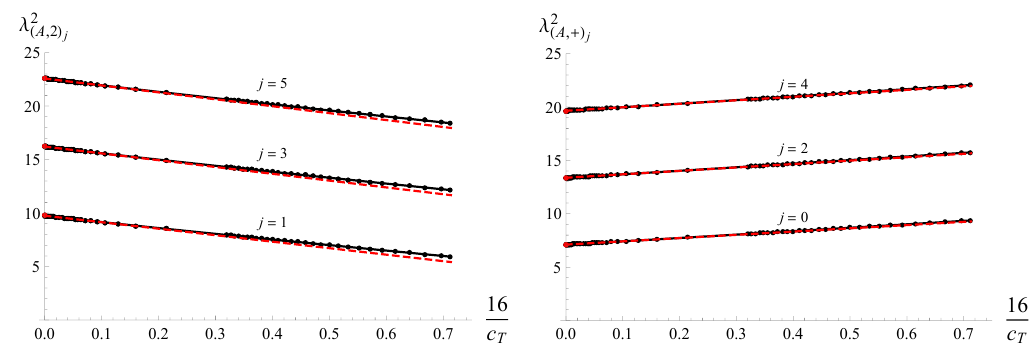
Figure 4 . The (cid:21) 2 and (cid:21) 2 OPE coe(cid:14)cients with spins j = 1 ; 3 ; 5 and j = 0 ; 2 ; 4, re- ( A; 2) j ( A; +) j spectively, in terms of the stress-tensor coe(cid:14)cient c T , where the plot ranges from the generalized free (cid:12)eld theory limit c T ! 1 to the numerical point 16 (cid:25) : 71 where (cid:21) 2 = 0. The red dots ( B; 2) c T denotes denote the known values at the generalized free (cid:12)eld theory points given in table 3, while the red dotted lines show the linear (cid:12)t for large c T given in (5.4). These bounds were computed with (cid:3) =